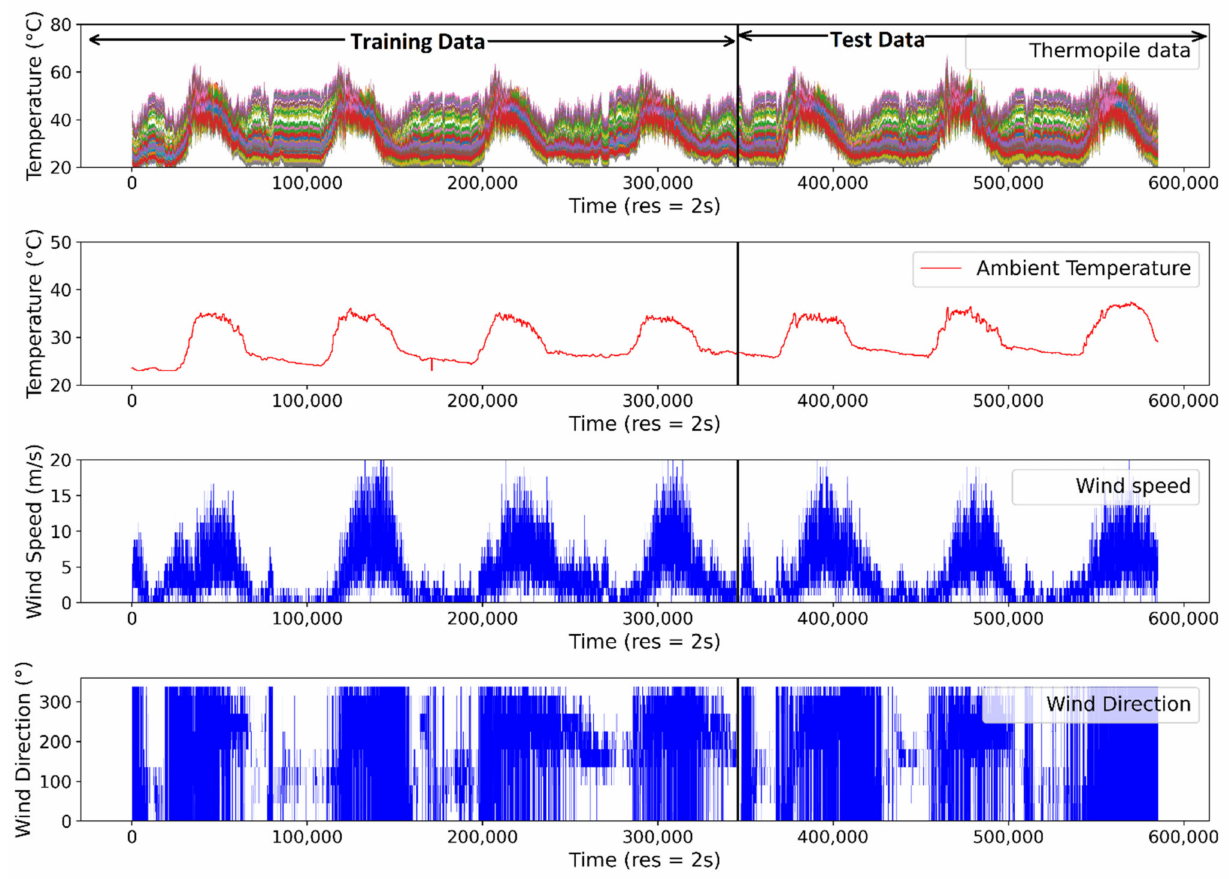
Figure 5. The plots of 168 h of data collected for this study, including thermopile array, ambient temperature, wind speed and wind